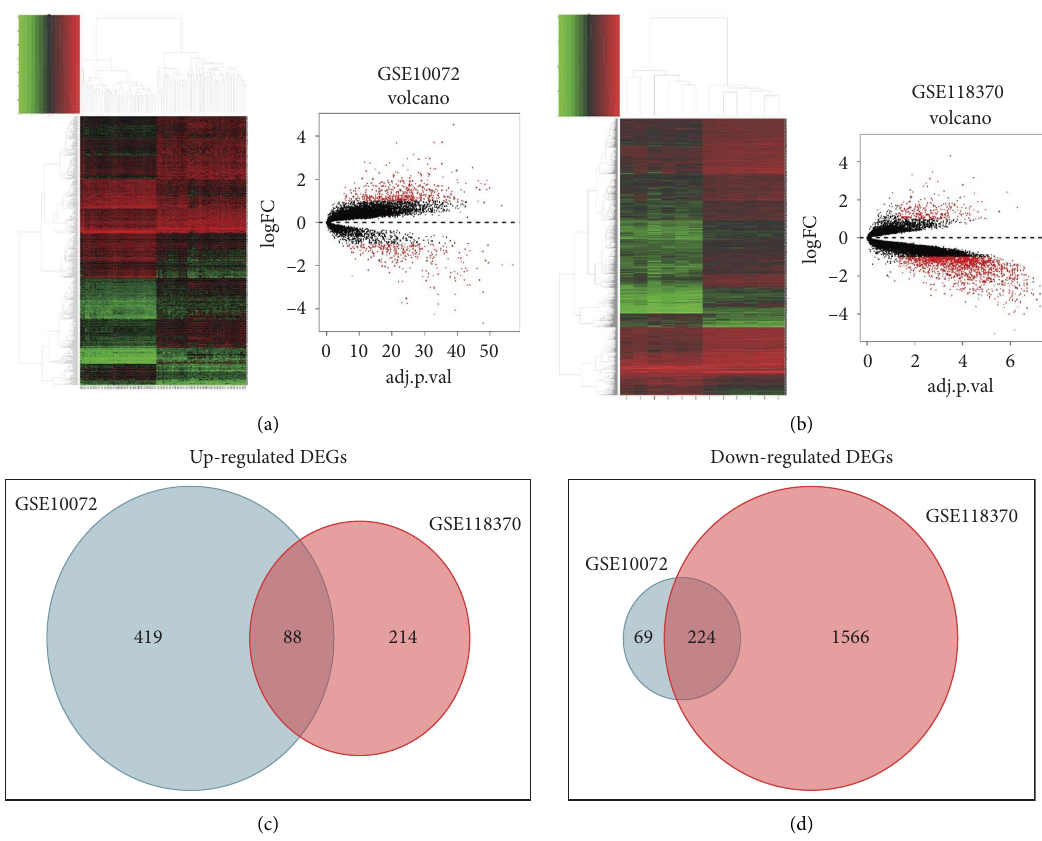
Figure 2: Identify DEGs shared between the two databases. (a) Te heat map and volcano map of GSE10072. (b) Te heat map and volcano map of GSE18370. (c) A Venn diagram used to identify 88 promising up-regulated target genes in lung adenocarcinoma. (d) A Venn diagram is used to identify 224 promising down-regulated target genes in lung